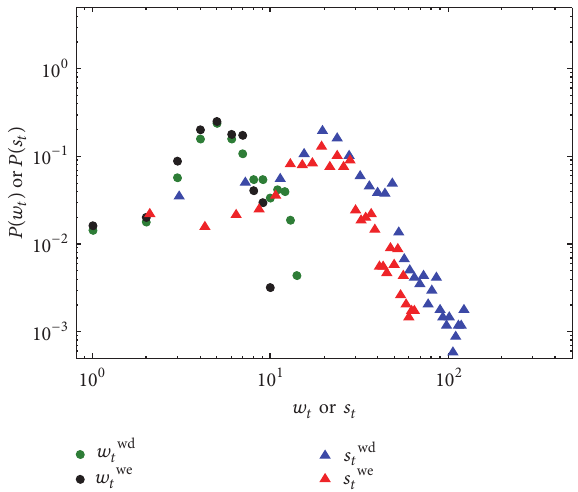
Figure 4: In TFN, flow weight and node strength distributions. The weights of train flow 𝑤 𝑡 wd and 𝑤 𝑡 we can be fitted by Weibull distributions with parameters 𝛽 = 3.13 and 𝜂 = 274.73 and 𝛽 = 3.69 and 𝜂 = 654.45 , respectively. The goodness-of-fit ( 𝑅 2 ) are 0.77 and 0.93. And the strengths 𝑠 𝑡 wd and 𝑠 𝑡 we can be fitted by Weibull distributions with parameters 𝛽 = 1.65 and 𝜂 = 219.64 and 𝛽 = 0.82 and 𝜂 = 16.64 , respectively. The goodness-of-fit ( 𝑅 2 ) are 0.90 and